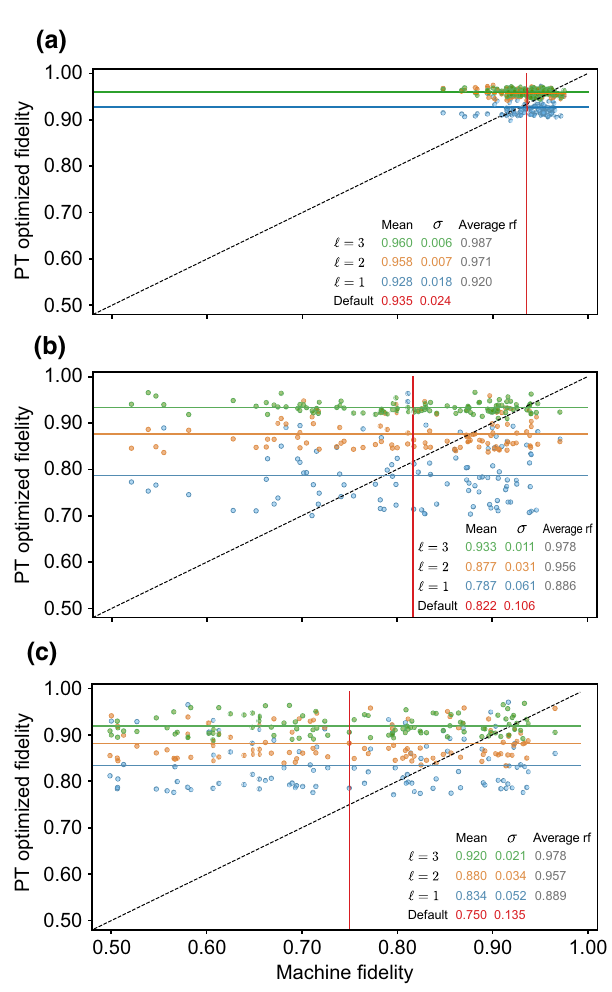
FIG. 10. The results of using conditional Markov models to improve the fidelities of a five-step circuit on ibmq_montreal and ibmq_guadalupe . We construct conditional Markov order mod- els for (cid:2) = 1, (cid:2) = 2, and (cid:2) = 3 across five steps under a variety of background conditions. For randomized inputs, these models are used to optimize the next four operations. The four optimal operations are then applied to each input and the results com- pared to the machine fidelity. The mean and standard deviation for each set of circuits is listed, as well as the average recon- struction fidelity of the models. (a) No background operations are applied. (b) The nearest neighbor to the system is initialized in a |+(cid:6) state. (c) Two nearest neighbors and one next-to-nearest neighbor from the system are initialized in a |+(cid:6)